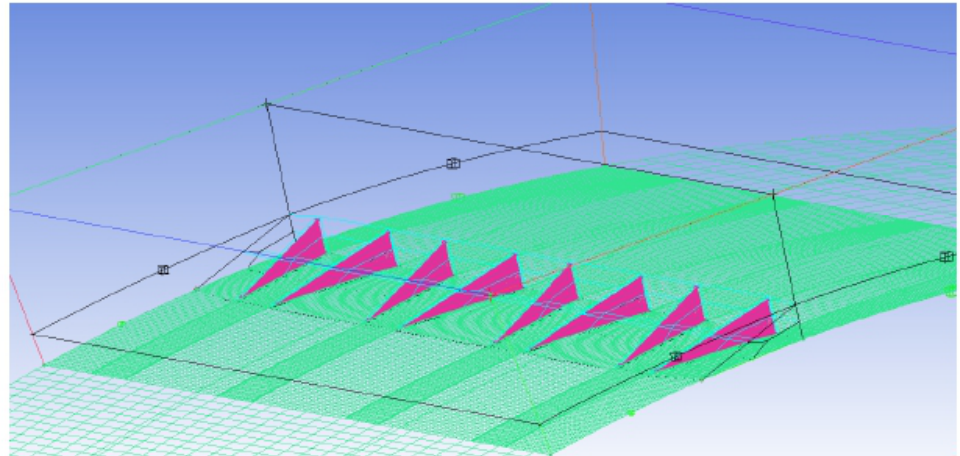
Figure 8. Schematic diagram of the grid near the vortex generators.